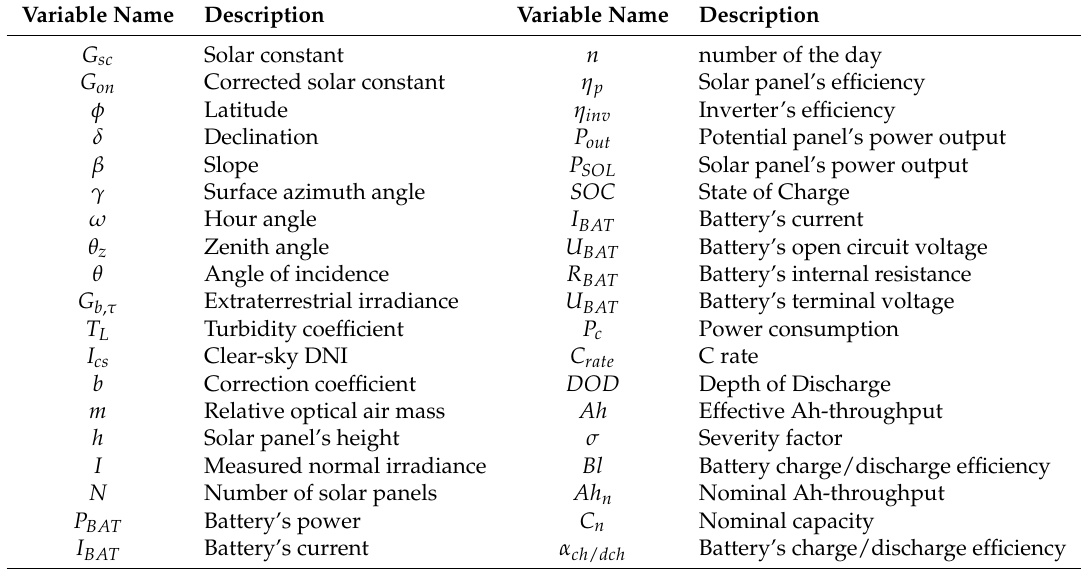
Table 1. Description of the model variables and